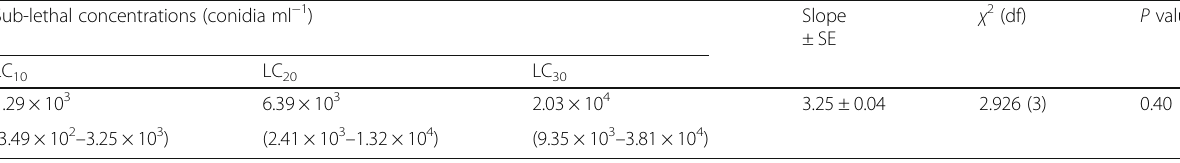
Table 1 Sub-lethal concentration values of Metarhizium anisopliae s.l. (isolate DEMI 001) on third-instar larvae of Tuta absoluta Sub-lethal concentrations (conidia ml − 1 )